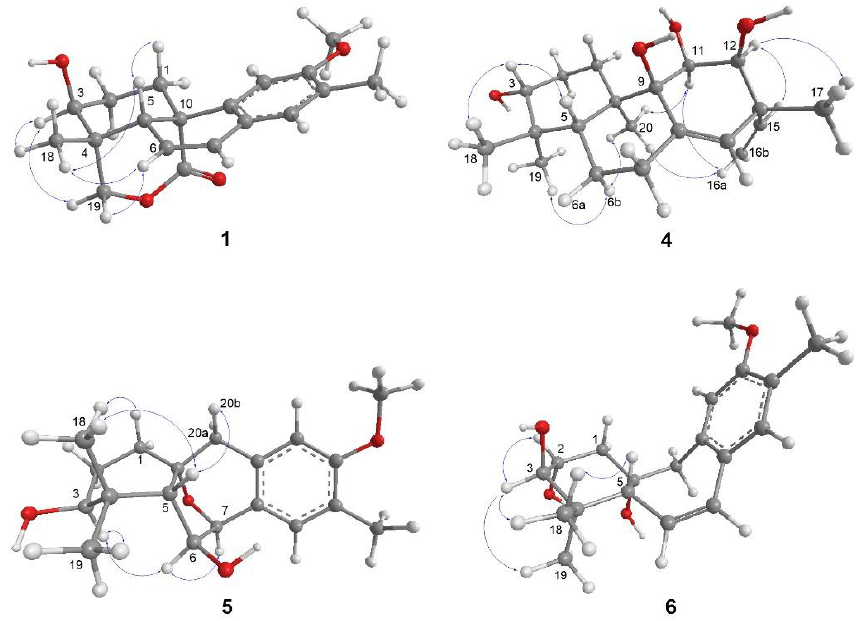
Molecules 2022 , 27 , x FOR PEER REVIEW 4 of 12 Figure 2. Selected 1 H − 1 H COSY ( ▬ ) and HMBC ( → ) correlations of 1 – 6 .